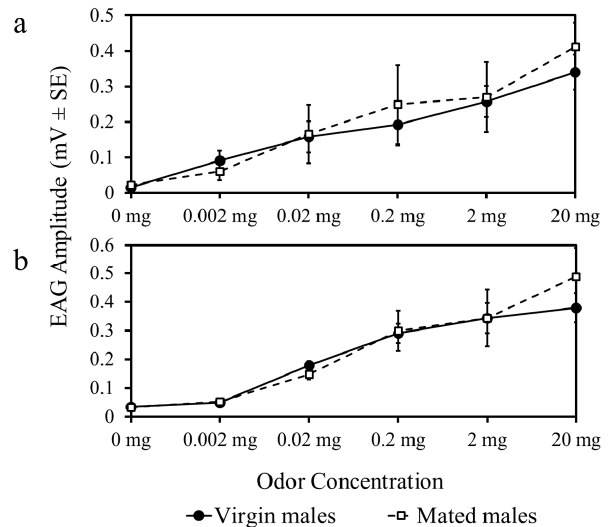
Figure 3. Antennal responses to female whole body extracts ( a ) and a stimulatory host-plant volatile, linalool ( b ), at increasing concentrations compared to an odorless blank (0 mg).